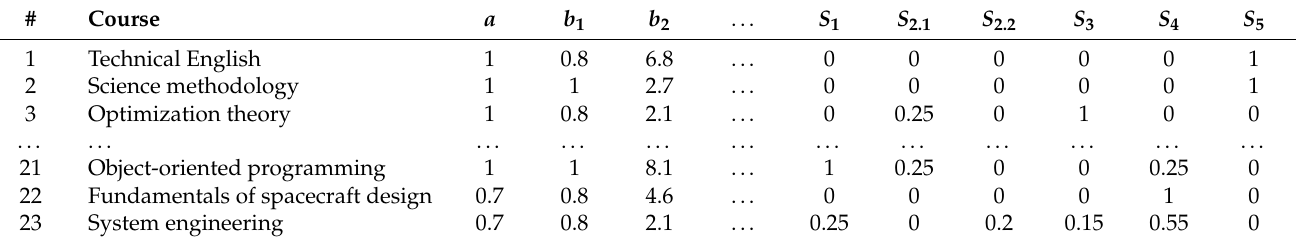
Table 2. Expert evaluations of the courses’ contribution to development of key professional skills (a